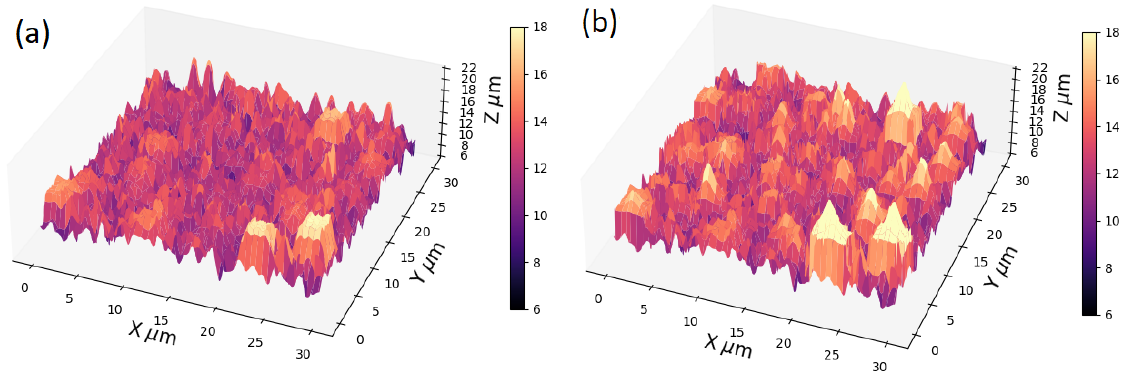
Figure 7. Three-dimensional surface for the elastomer-magnetic particle system for test 2 with RMS height of 2 µ m, τ x = 0.4 µ m, and τ y = 0.4 µ m ( a ) Initial surface without modification. ( b ) Surface modified by the movement of the